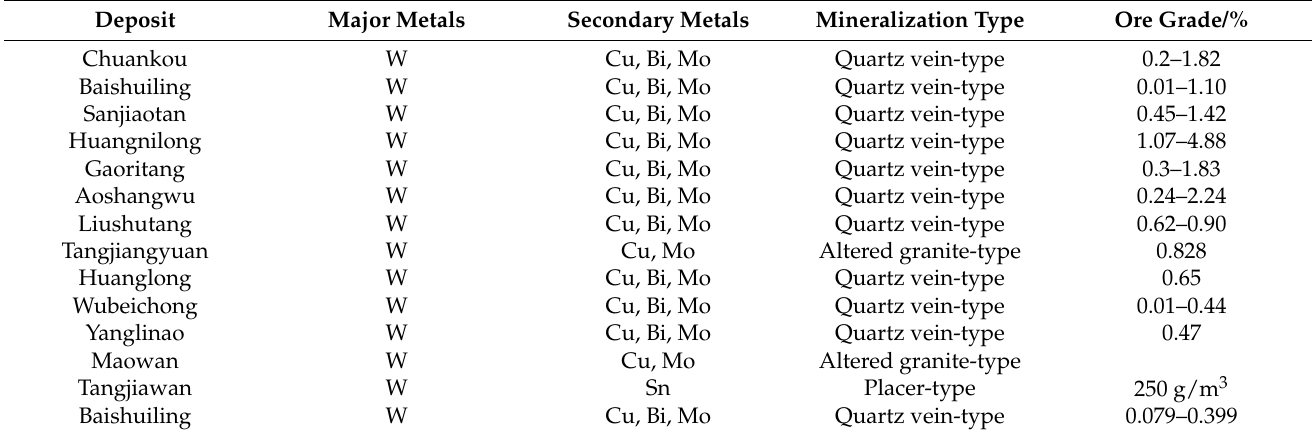
Table 1. The mineralization characteristics of Chuankou ore